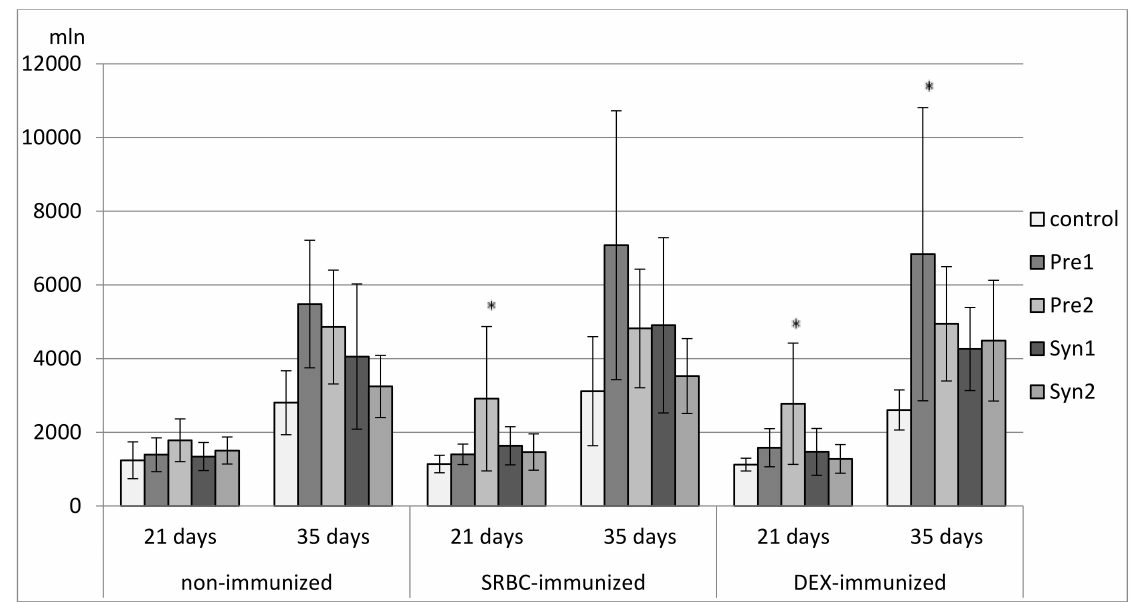
Figure 3. The total count of CD4 + CD8 + cells in the thymus of chicken broilers after in ovo injection of the investigated prebiotics or synbiotics. The data are expressed as the mean ± SD. Data with a symbol (*) denote a significant difference with respect to the control group ( p <